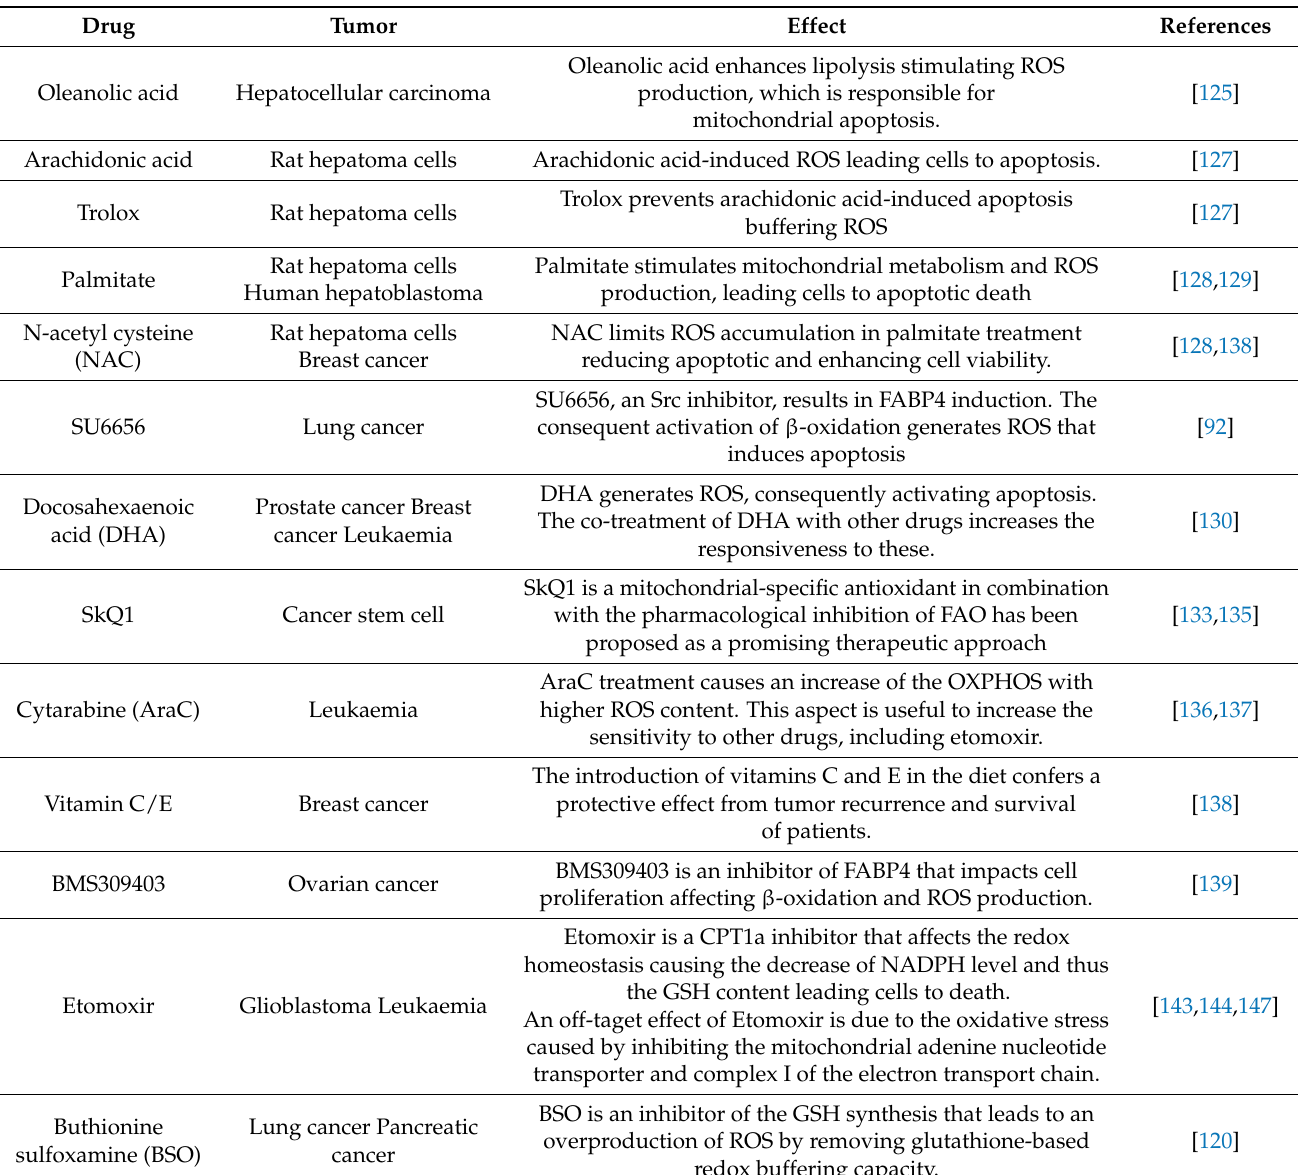
Table 1. List of studies evaluating the effects of compounds inducing FAO and the standard therapy combination in tumor treatment. Drug Tumor